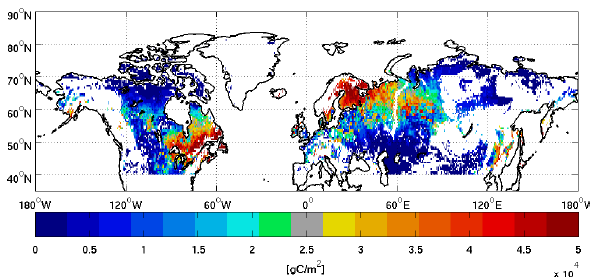
Fig. 6. Peat carbon density increase, relative to grid cell (not wet- land fraction), accumulated over the last